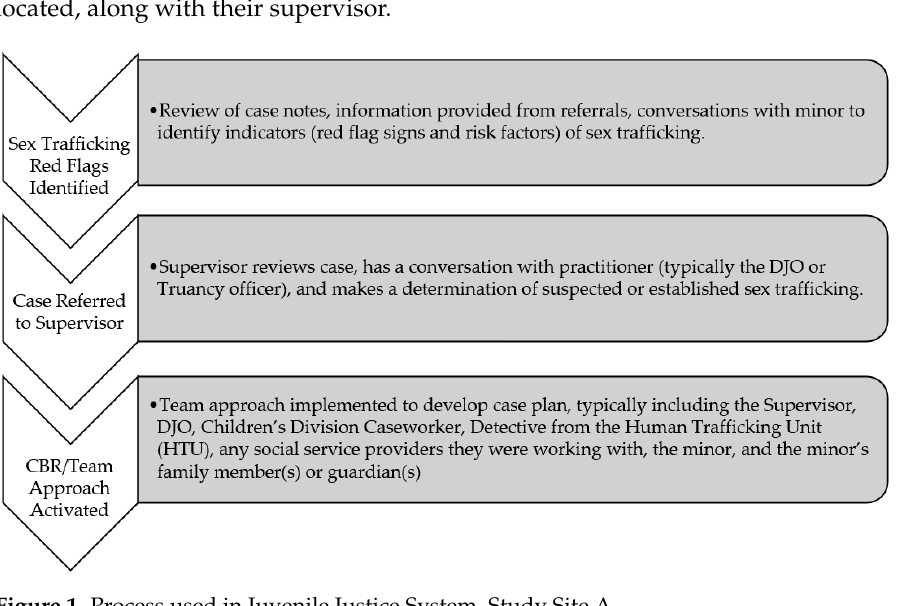
Figure 1. Process used in Juvenile Justice System, Study Site A.